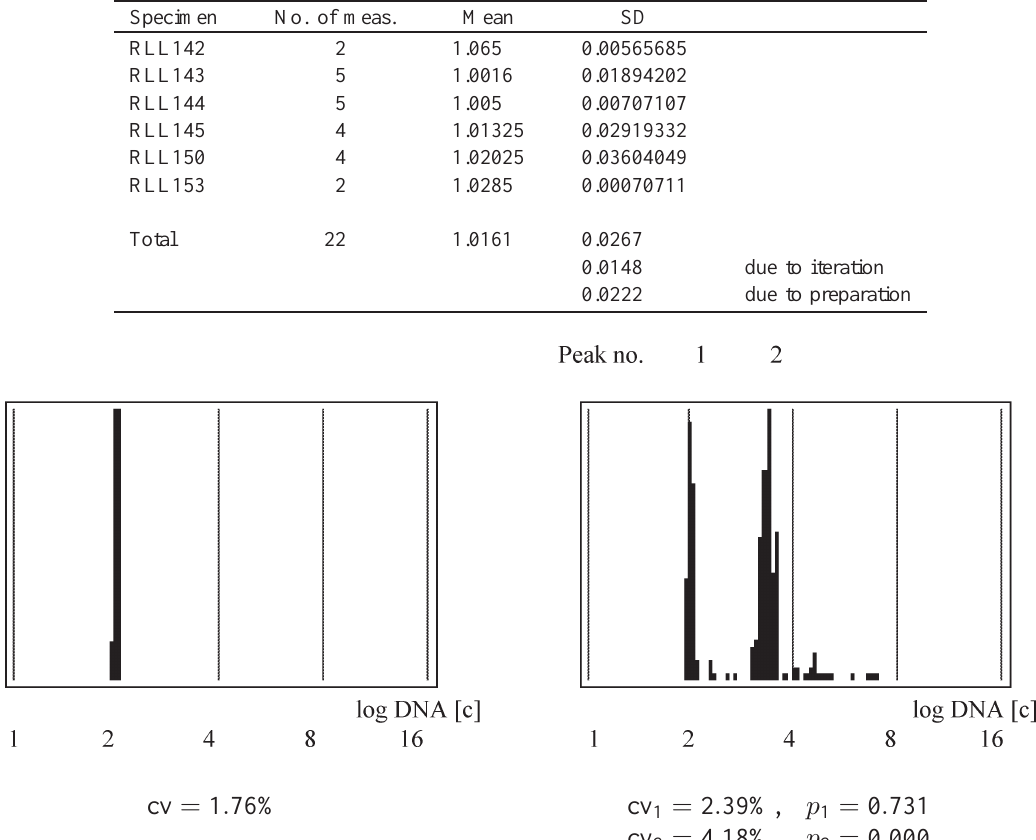
Fig. 6. DNA histograms of the reference cells (left) and the analysis cells (right) of an aneuploid breast cancer. Beside a diploid peak an aneuploid stemline is proven at 3.35 c with p = 0 . 00 (peak no. 2). If the latter Eqs (6) and (7) are applied to each DNA-stemline, then error probabilities show